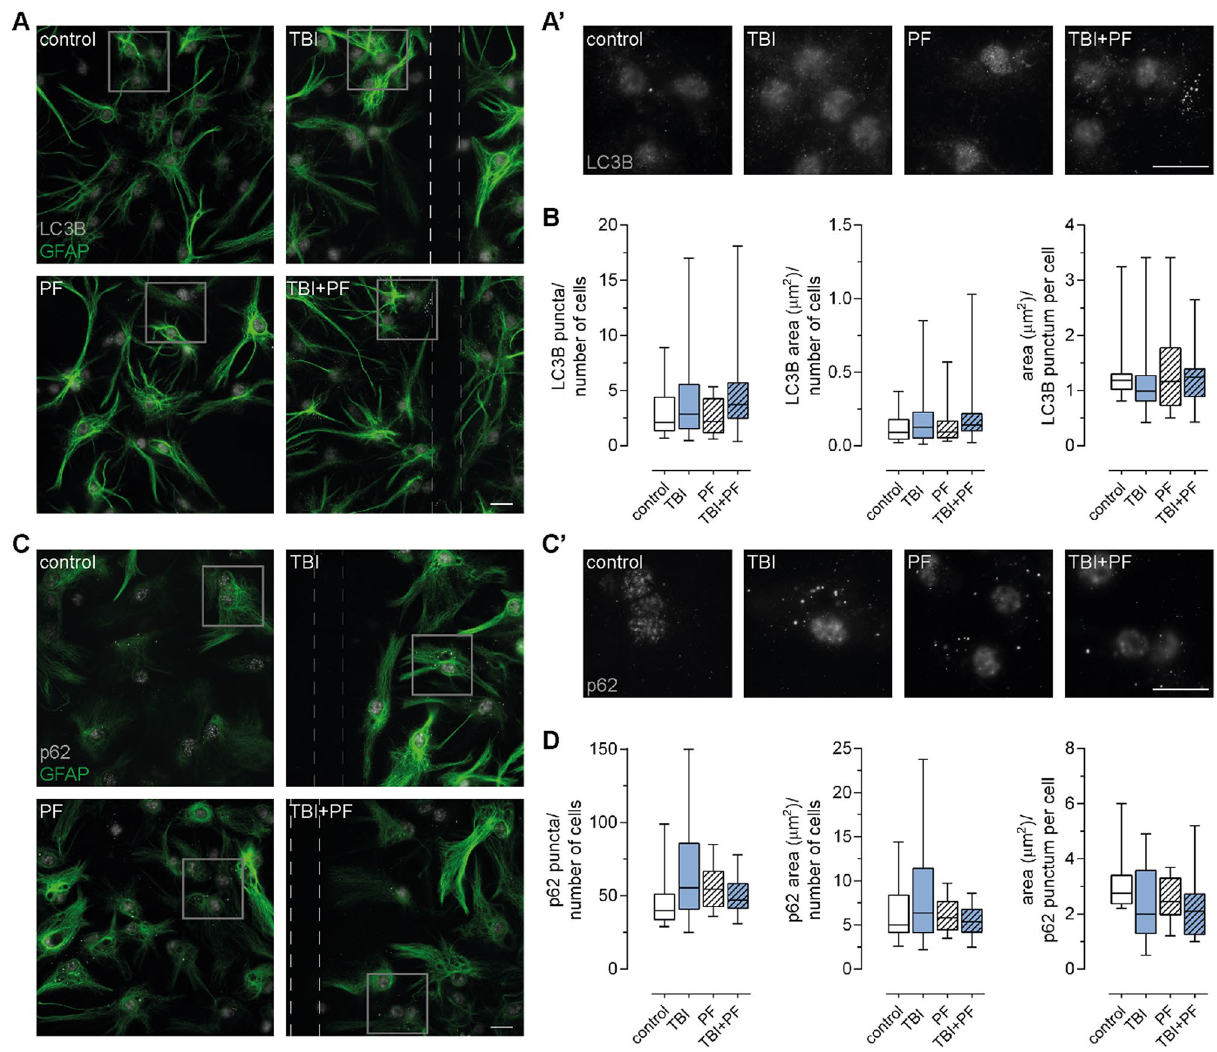
Figure 7. Immunocytochemistry confirms that the autophagy-lysosomal pathway is not impaired. ( A ) Immunostaining for LC3B and astrocytes (GFAP) were performed and representative fluorescence microscopy images are shown. ( B ) The number of LC3B puncta and their total area as well as the area per single LC3B-positive punctum were quantified. While the analysis did not reveal statistically significant differences, it was observed that some cells, in cultures that had undergone TBI alone or in combination with Aβ 42 protofibril exposure, possessed higher amounts of LC3B puncta and subsequently also a greater total area measurement. ( C ) Representative images of cultures stained for p62 and astrocytes (GFAP) and ( D ) the quantification of p62 puncta, total area measurement and area per single p62-positive punctum. Again, cells in the TBI group occasionally possessed a much higher number of p62 puncta and total area measurement, albeit no statistically significant difference. The general tendency for an increase in p62 expression in the TBI and PF groups, observed in the immunoblotting data, was also identified in this image analysis. ( A ′ , C ′ ) Magnifications of the areas outlined in ( A ) or ( C ) are presented. Ten or five (LC3B and p62, respectively) images per independent cell culture (n = 2) per experimental group were analyzed and reported. Statistical analysis was performed using the Kruskal–Wallis test followed by Dunn’s multiple comparisons test, *p ≤ 0.05 **p ≤ 0.01 ***p ≤ 0.001. Scale bars 20